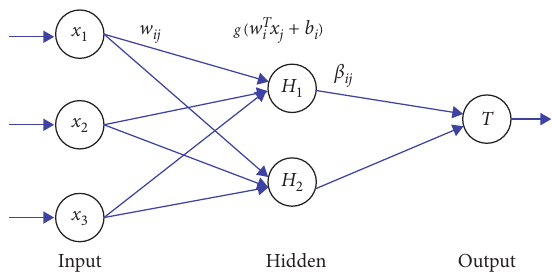
Figure 4: Schematic diagram showing the basic structure of an extreme learning machine.